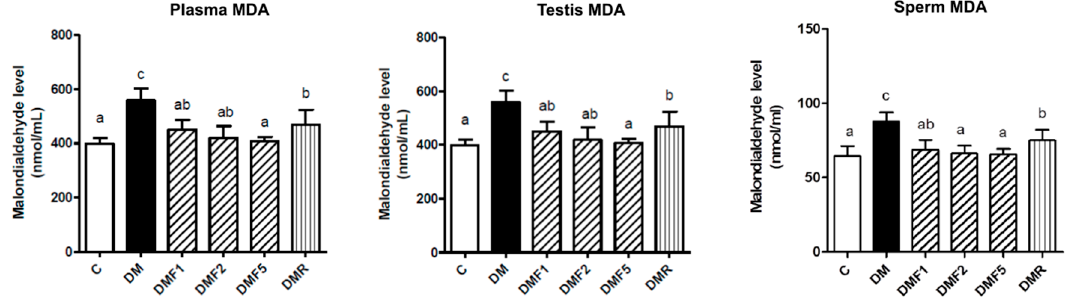
Figure 4 . Effects of fucoxanthin on malondialdehyde (MDA) level in rat plasma, testis, and sperm after treatment for four weeks. Data are shown as the mean ± S.D. ( n = 5). The values with different letters (a–c) represent significant differences ( p < 0.05) as analyzed by Duncan’s multiple range test. C, control; DM, diabetes; DMF, diabetes treated with fucoxanthin; DMR, diabetes treated with rosiglitazone.